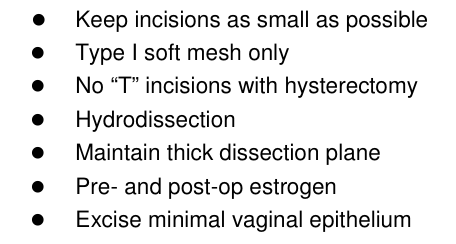
Minimizing Risks of Mesh